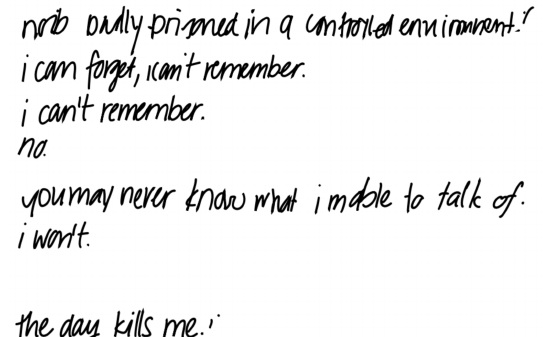
Figure 1. Some examples of Paranoid Transformer diary entries. Three entries of varying length.